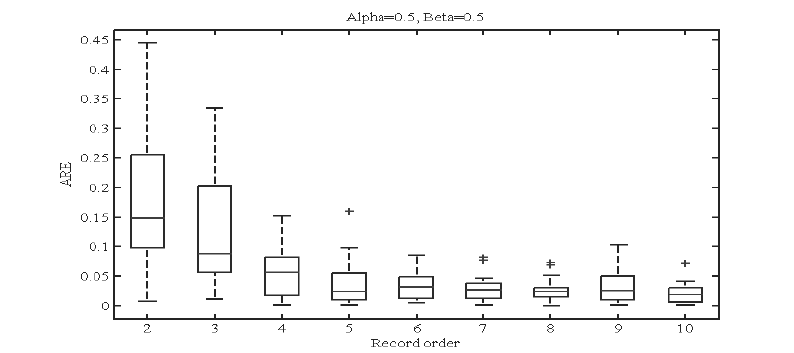
Figure 1 – Skewness coefficient of records.